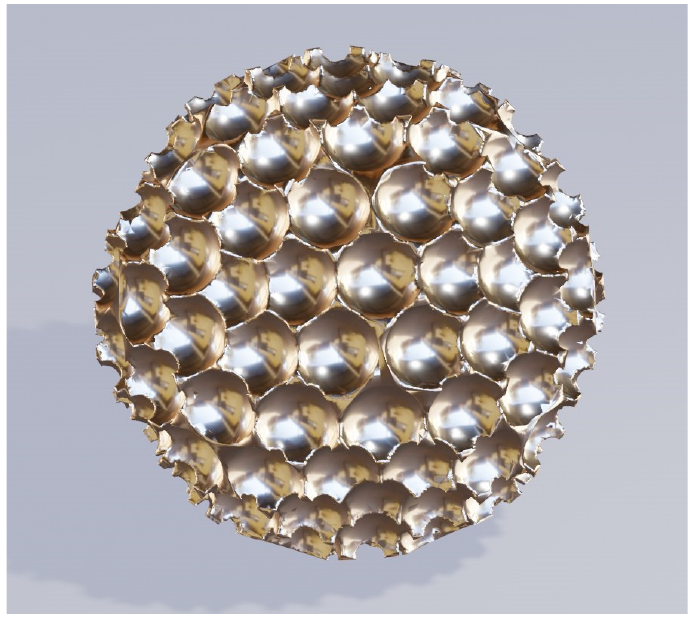
Figure 2. Metal replica of the Oncometopia cratered brochosome-like shell.